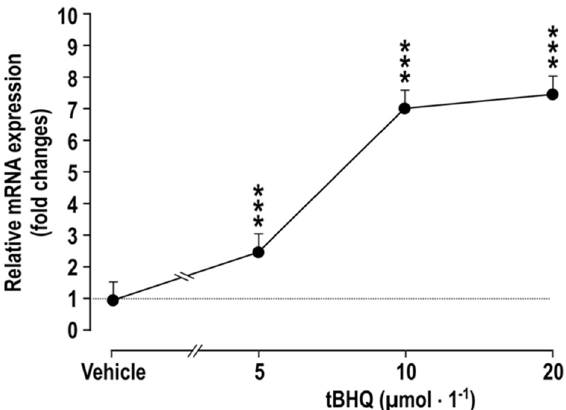
Figure 1. Incubation of vascular smooth muscle cells with tBHQ for 24 h causes dose-dependent increases the mRNA expression of COX2, compared to vehicle-treated controls. Mean ± SEM values ( n = 5). Compared to vehicle: ***, p < 0.005.